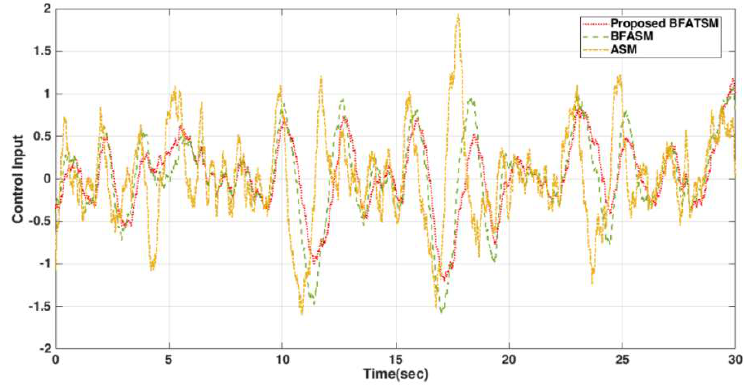
Figure 6. Input control of ASM [1] compared to BFATSM [2].